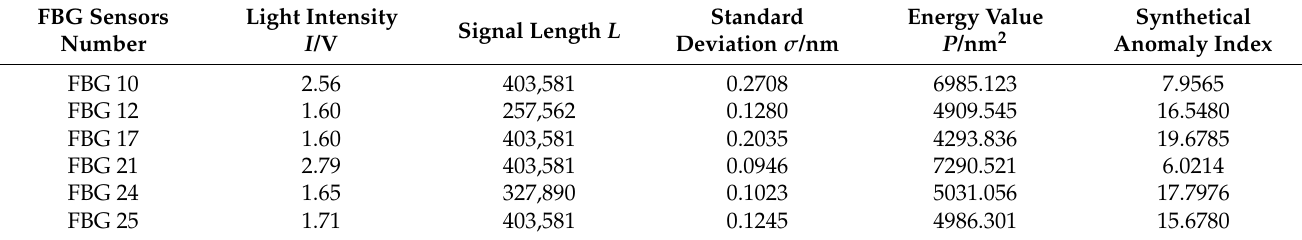
Figure 12. Diagram of faulty FBG sensors on airplane. ( a ) Falling off; ( b ) Broken optical cable; ( c ) Excessive bending.